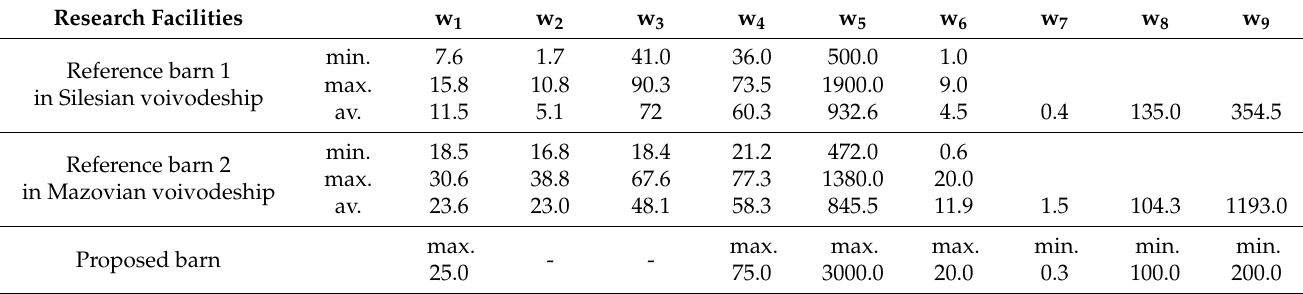
Table 5. Qualitative indicators, including the microclimate in the reference and proposed cowshed (own